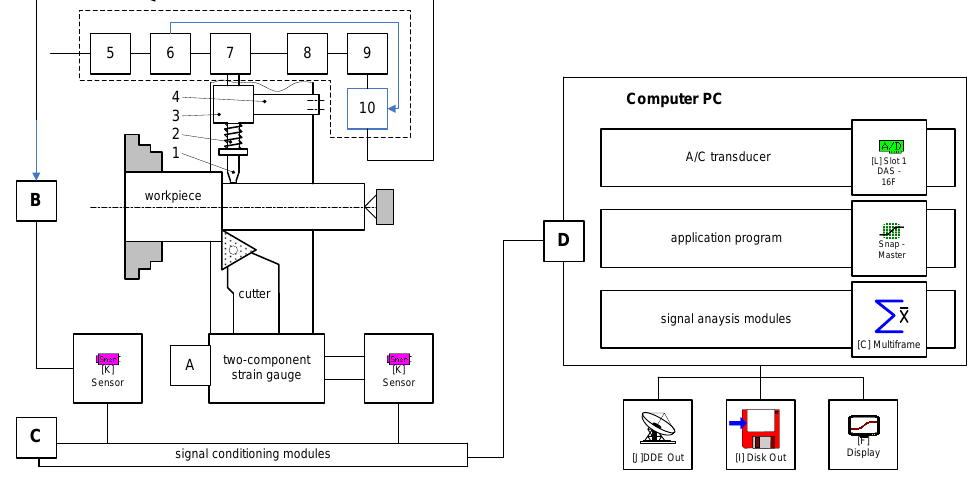
Figure 2. Schematic of the test bench.